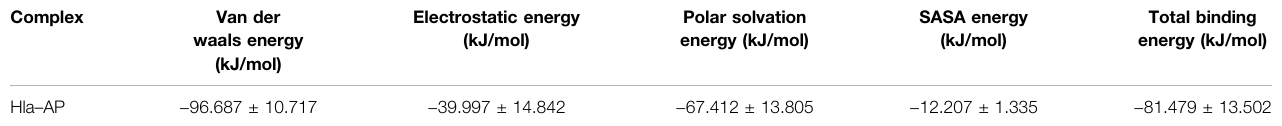
TABLE 1 | MM-PBSA-based total binding free energies along with its constituent energies for the selected bioactive molecules.